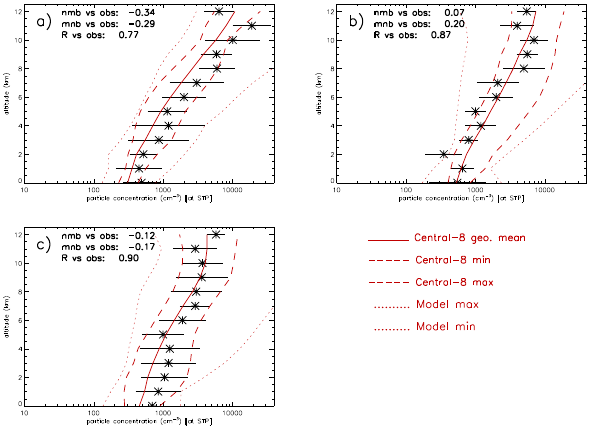
Figure 22. Simulated vertical profile of marine size-resolved N 3 profiles over the Pacific and Southern Oceans compared to observed compilation of aircraft-borne u-CPC measurements as compiled in Clarke and Kapustin (2002). Model values are averages over grid boxes in the latitude ranges a) 70 to 20 ◦ S, b) 20 ◦ S to 20 ◦ N and c) 20 to 70 ◦ N. Longitude ranges used to sample the models were a) 185 to 90 ◦ W), b) 160 to 120 ◦ W) and c) 135 to 180 ◦ E respec- tively. These averaged profiles for each model were interpolated onto a 1km vertical grid. Again, since the measurements are taken over many different seasons, annual mean values were used when constructing the multi-model quantities. The solid line shows the geometric mean of the central-8 models, dashed lines indicate the maximum and minimum of the central-8, while dotted lines indicate the maximum and minimum over all 12 models. Note that model particle concentrations have been converted to values at standard temperature (300K) and pressure (1000hPa) to be consistent with these u-CPC measurements. In all other figures measured and model values are at ambient